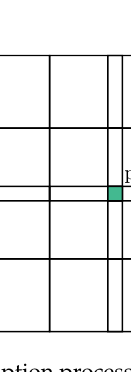
Figure 9. Pattern used during the description process. It defines areas to be extracted around a feature